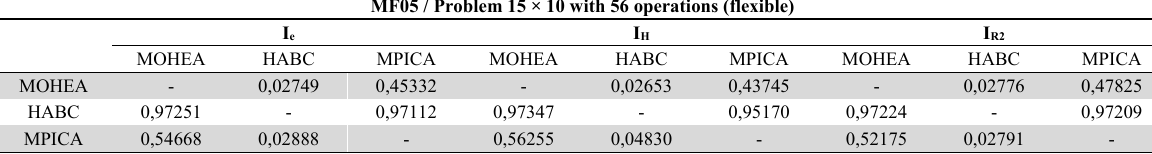
I e , I H , and I R2 (MF05) for HABC, MPICA and MOHEA MF05 / Problem 15 × 10 with 56 operations (flexible)